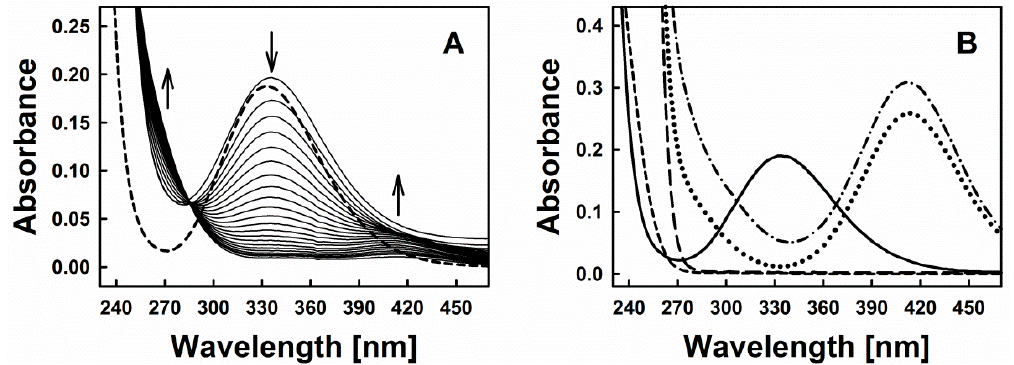
Figure 2. ( A ) Time resolved absorption spectra of 200 µM GSNO (dashed line) and after addition of 200 µM DATS and 800 µM Cys (spectra were recorded every 30 s); ( B ) Absorption spectrum of 200 µM GSNO (solid line); 2 mM H 2 S (prepared from Na 2 S·9 H 2 O, long-dashed line); 2 mM DTT (short-dashed line); spectrum of the mixture of 200 µM GSNO with 2 mM H 2 S after 5 min of their interaction (dash-dotted line) and spectrum of the same mixture treated 10 min with 2 mM DTT (dotted line).